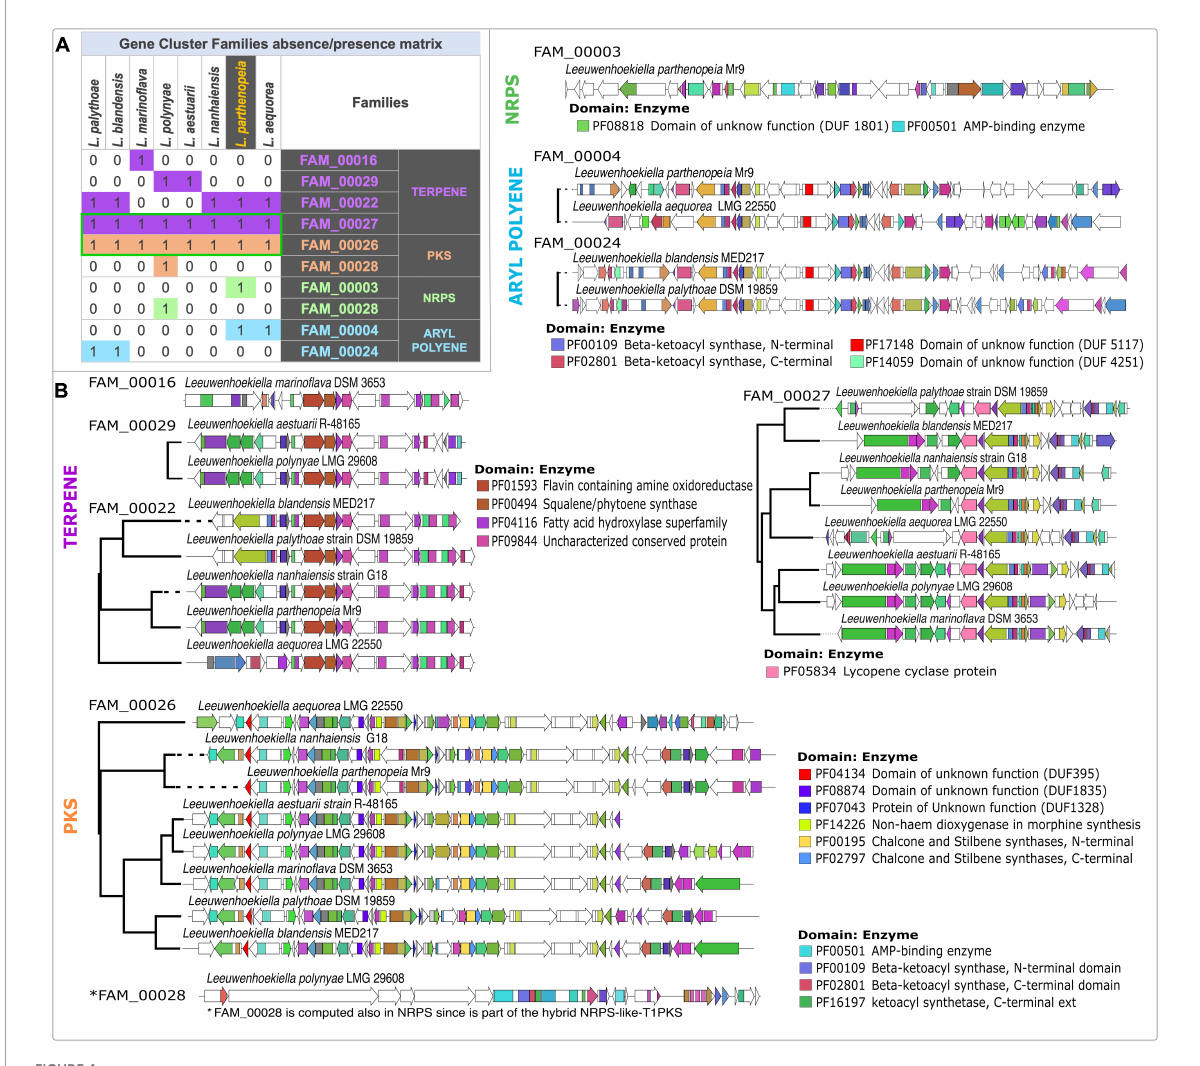
FIGURE4 (A) Similarity network matrix based on the absence and presence of gene cluster families from each species of the genus Leeuwenhoekiella . Green boxes, gene cluster families (GCFs) are present in all members of Leeuwenhoekiella . (B) Multi-locus approximately maximum-likelihood trees based on the conserved core common